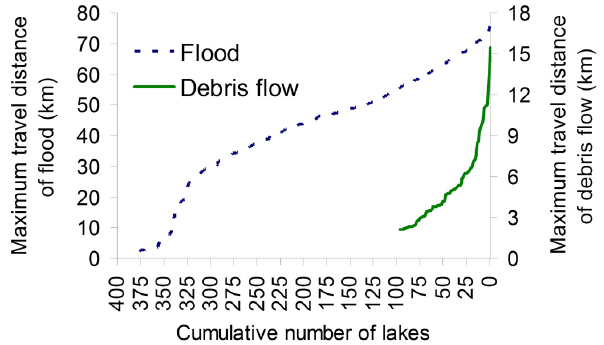
opment of Lake V1 1968–2007. (c) Impact susceptibilities I for potential outbursts of Lake V1 and Lake